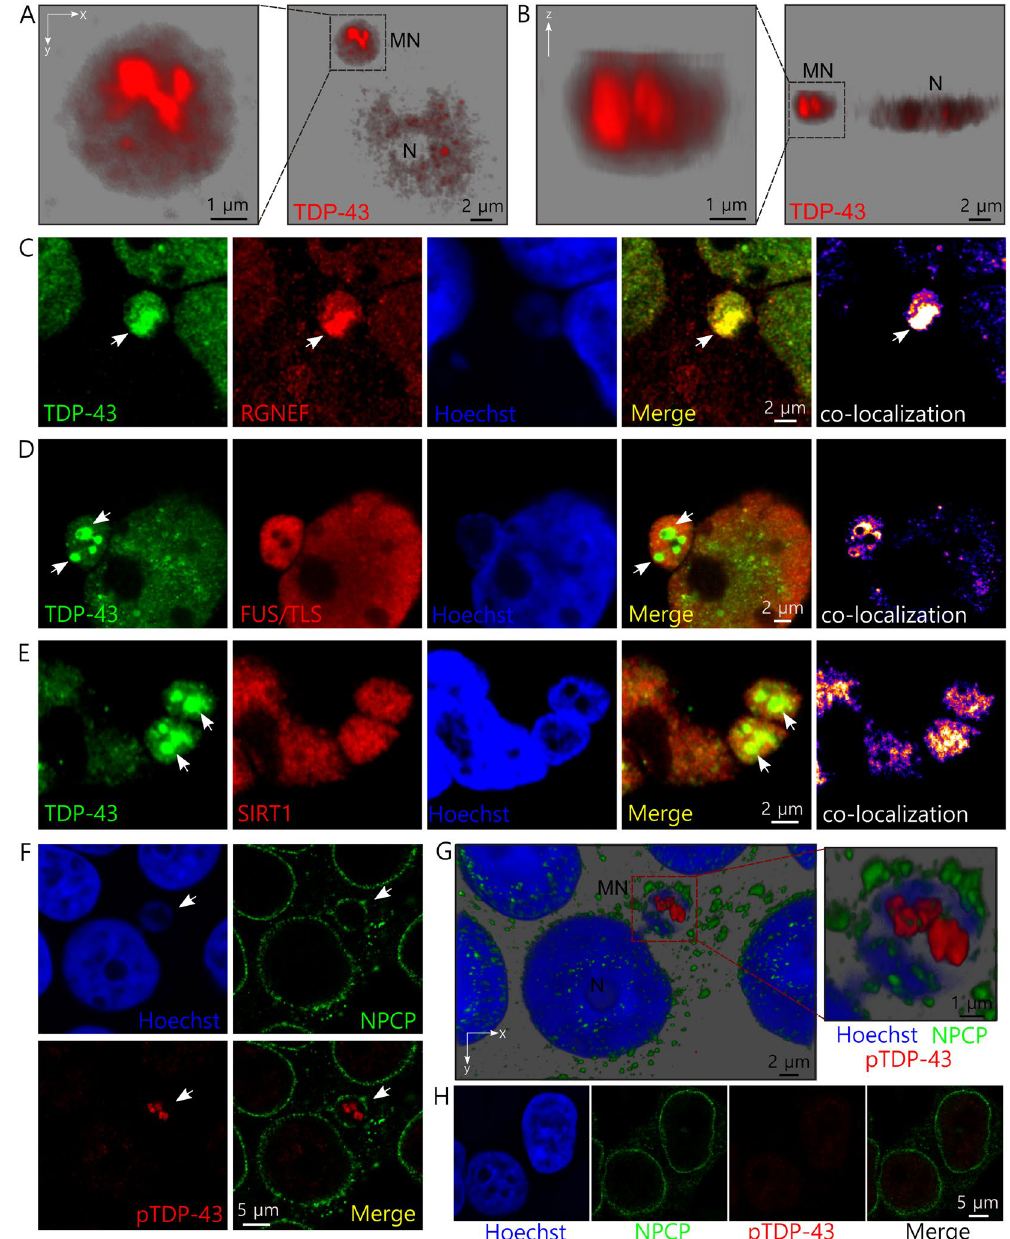
Figure 4. TDP-43 forms inclusions within micronuclei induced by metabolic stress which co-aggregate with endogenous RGNEF in HEK293T cells. ( A , B ) 3D reconstruction from confocal set of images of a HEK293T cell showing TDP-43 aggregates within a micronucleus after cellular metabolic stress using lactate. ( A ) Shows xy axis view and ( B ) shows z axis view of the cell. MN = micronucleus and N = nucleus. ( C ) Co-aggregation between endogenous TDP-43 and endogenous RGNEF within a micronucleus after metabolic stress in HEK293T cells (white arrows). ( D , E ) Absence of aggregate formation for FUS/TLS ( D ) and sirtuin 1(SIRT1) ( E ) within micronuclei in HEK293T cells. TDP-43 inclusions are indicated (white arrows). ( F ) TDP-43 aggregates within micronuclei in HEK293T after metabolic stress cells are immunoreactive for phospho(409/410)-TDP-43 antibody which only stain insoluble inclusions. ( G ) 3D reconstruction from confocal set of images of the cell in ( F ) showing the phospo(409/410)-TDP-43 positives aggregates. ( H ) Control HEK293T cells showing absence of immunoreactive for phospho(409/410)-TDP-43 antibody. Immunofluorescence primary antibodies used were anti-TDP-43, anti-RGNEF, anti-FUS/TLS, anti-sirtuin 1 (SIRT1) and anti-NPCP. Hoechst was used as nucleic acid staining. Scales are indicated in the